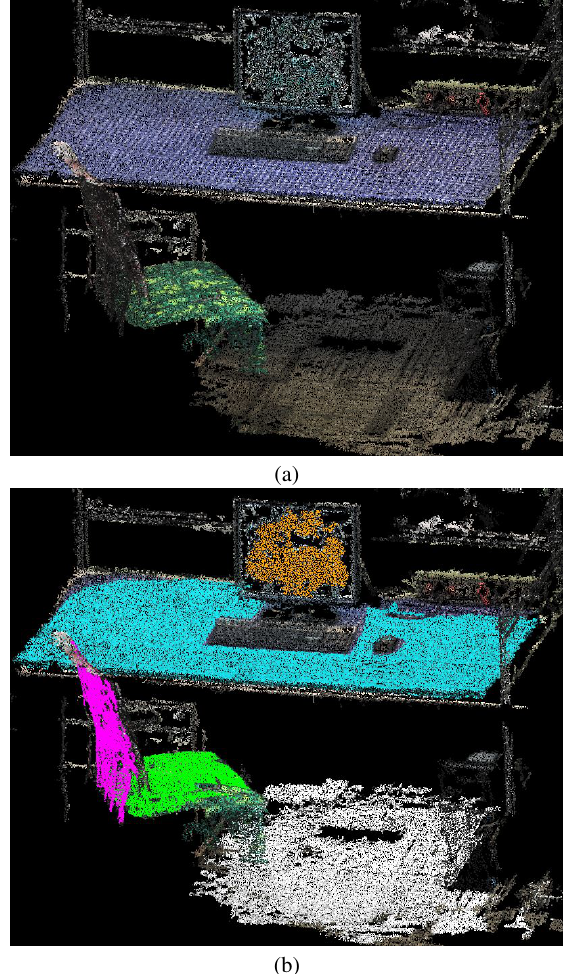
Figure 10: Image (a) illustrates the original cloud whilst (b) illus- trates the identified segments - those in white represent the floor, green the chair seat, pink the backrest, blue the desk, and orange an unclassified vertical